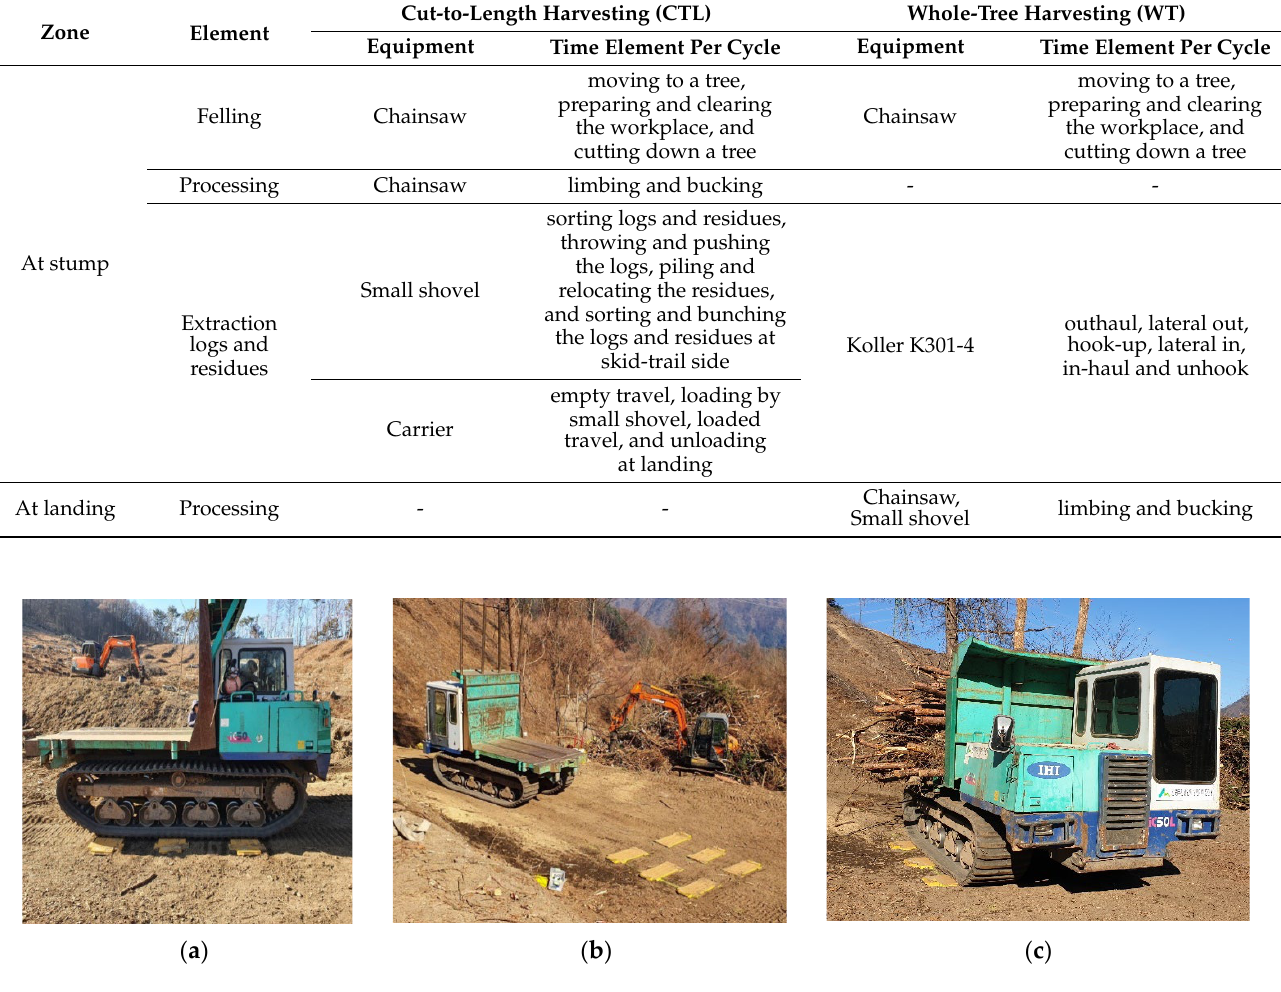
Figure 3. Overview of the logging residue weight measurement test: ( a ) measuring the empty carrier weight, ( b ) weighing the axle load scale layout, and ( c ) measuring the biomass weight with a carrier machine.